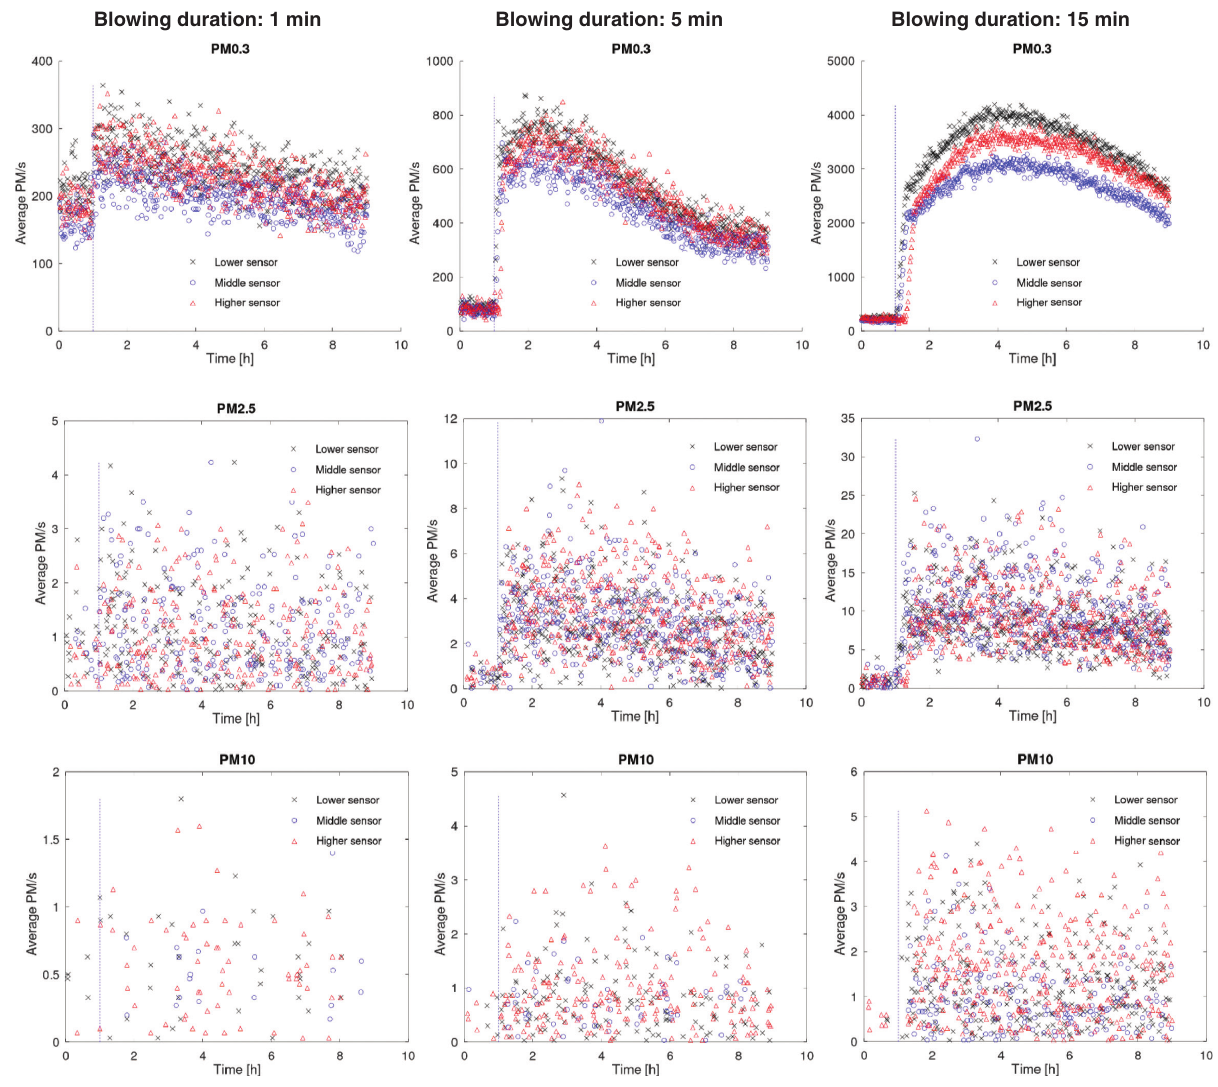
Figure 7 Measurements of PM0.3, PM2.5 and PM10 at different heights for 3 blowing durations (1 min, 5 min and 15 min). The blue vertical dashed line represents the commencement of the blowing. (Source: Authors,